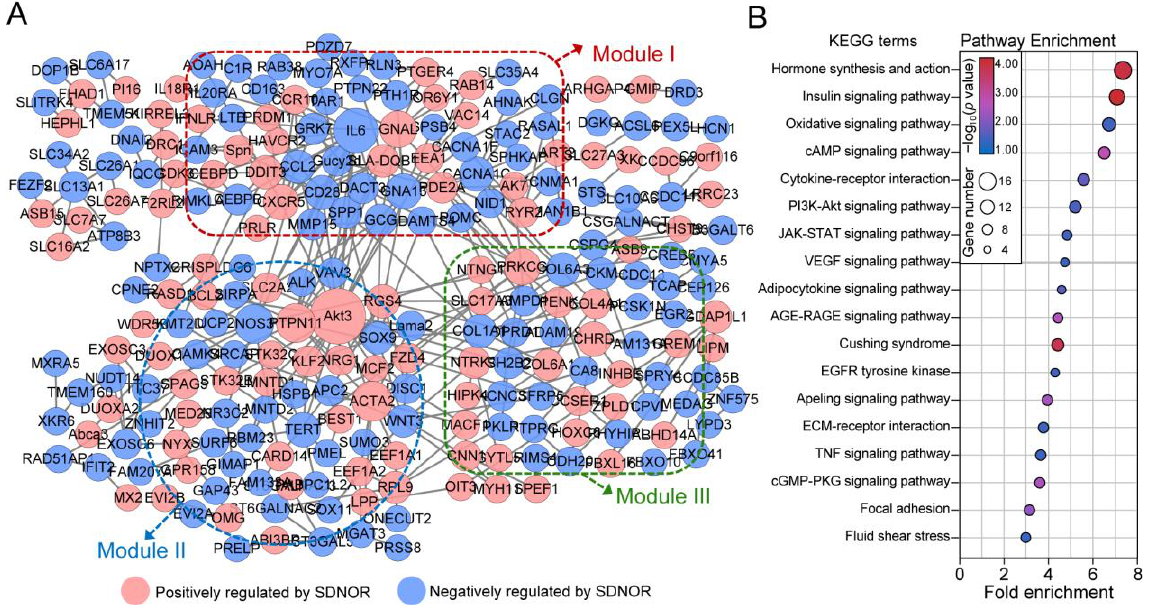
Figure 3. Establishment and functional analyses of the SDNOR-mediated PPI network. ( A ) The SDNOR-mediated PPI network was established with the DEmRNAs obtained from RNA-seq data. The nodes in red and blue indicate the protein-coding DEmRNAs which are positively or negatively regulated by SDNOR, respectively. The size of nodes depicts the interaction degree. The dotted areas indicate three significant modules (module I in red, II in blue, and III in green). ( B ) KEGG analyses of the three modules in the PPI network.